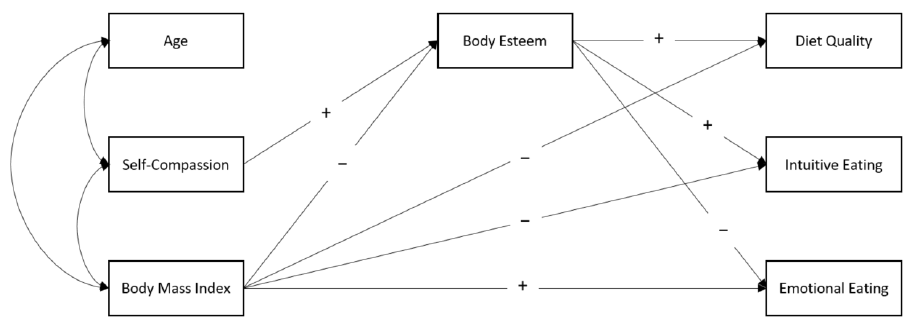
Figure 1. Hypothesized model. Note: The plus sign indicates that a positive link is expected; the minus sign indicates that a negative link is expected.